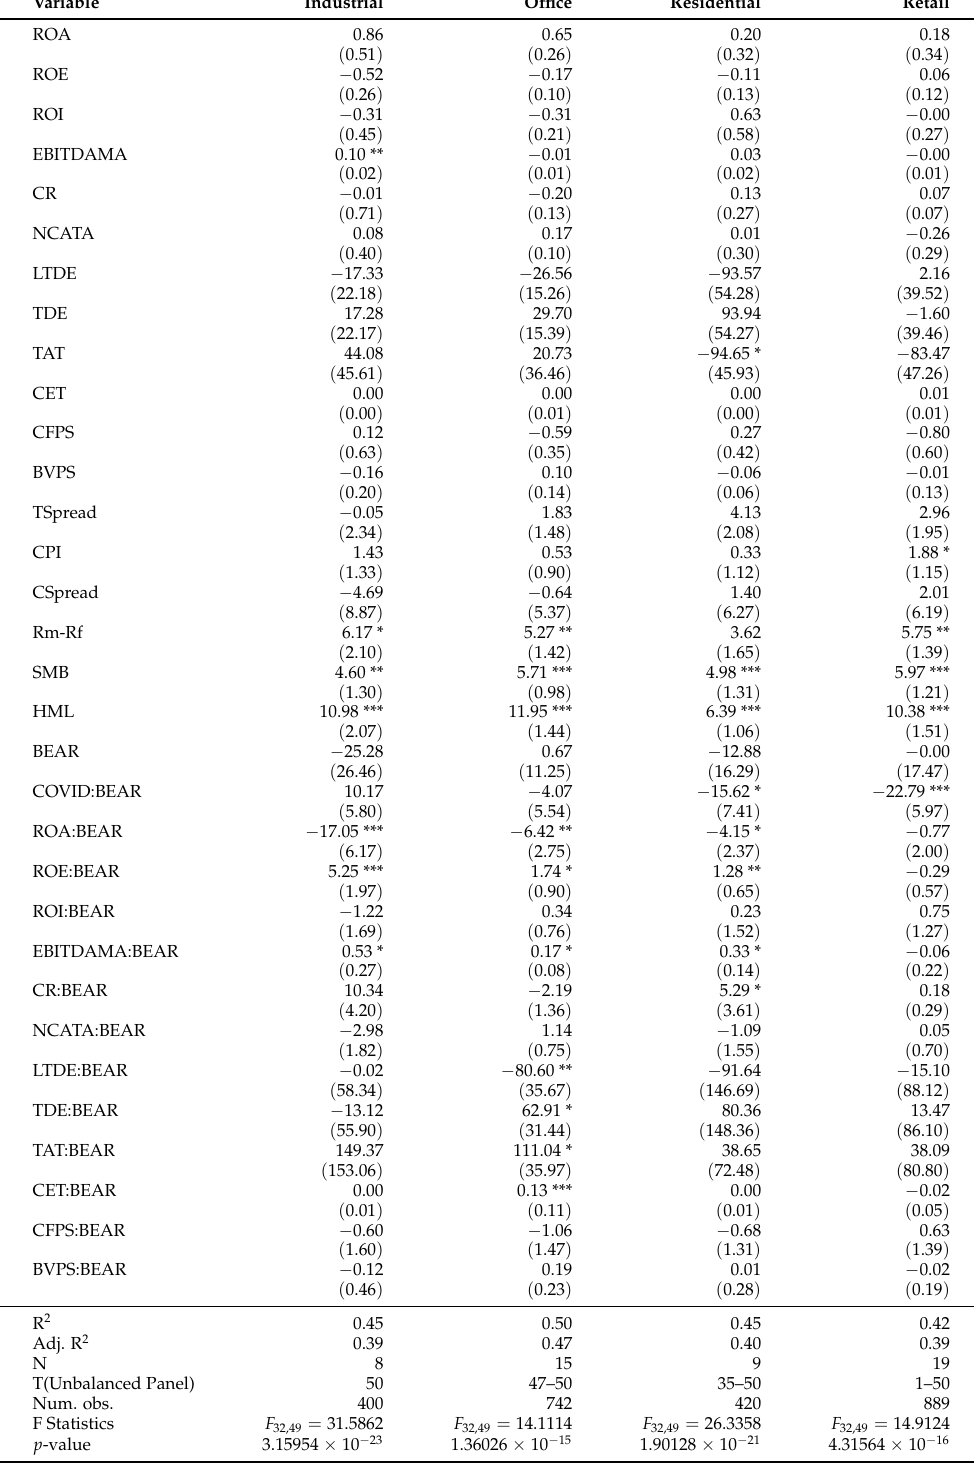
Table A8. Model Result—Specification